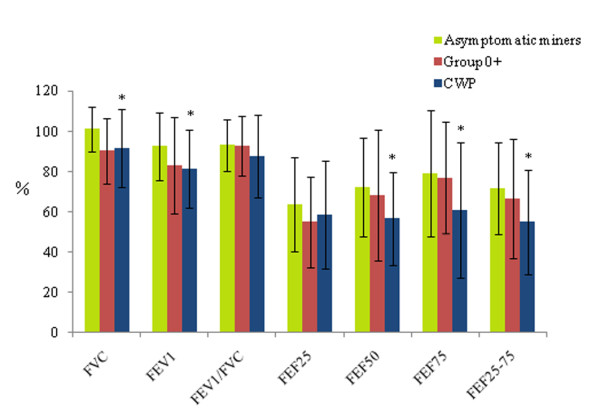
Comparisons of Lung Ventilation Functional Parameters among Patients with CWP and two Control Groups. The percent predicted values of FVC, FEV1, FEF50, FEF75, and FEF25-75 in patients with CWP were significantly decreased when compared with the respective parameters in asymptomatic miners: compared with asymptomatic miners, p < 0.05.